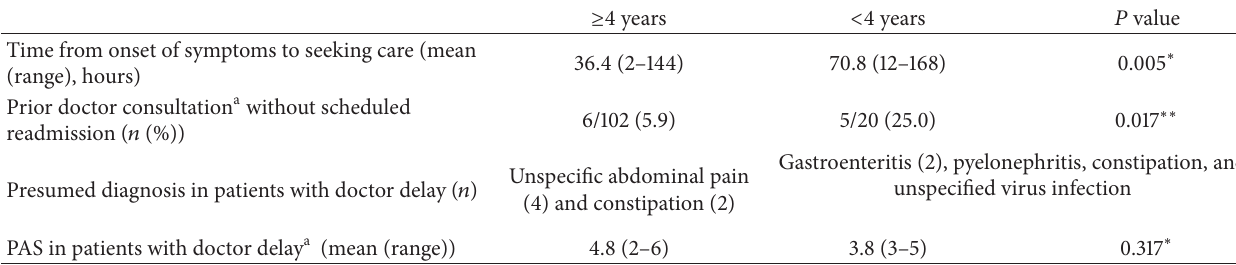
Table 3: Parent and doctor delays.